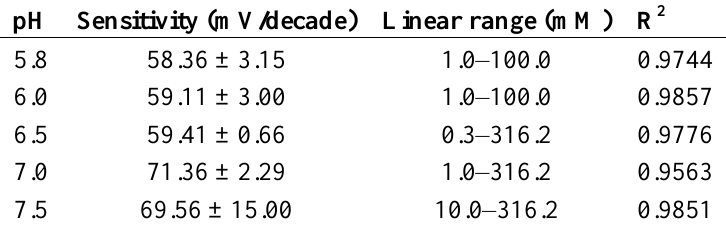
Table 3. The effect of pH of the buffer on the response of the formaldehyde biosensor (n = 3, 10 mM Tris-HCl buffer).